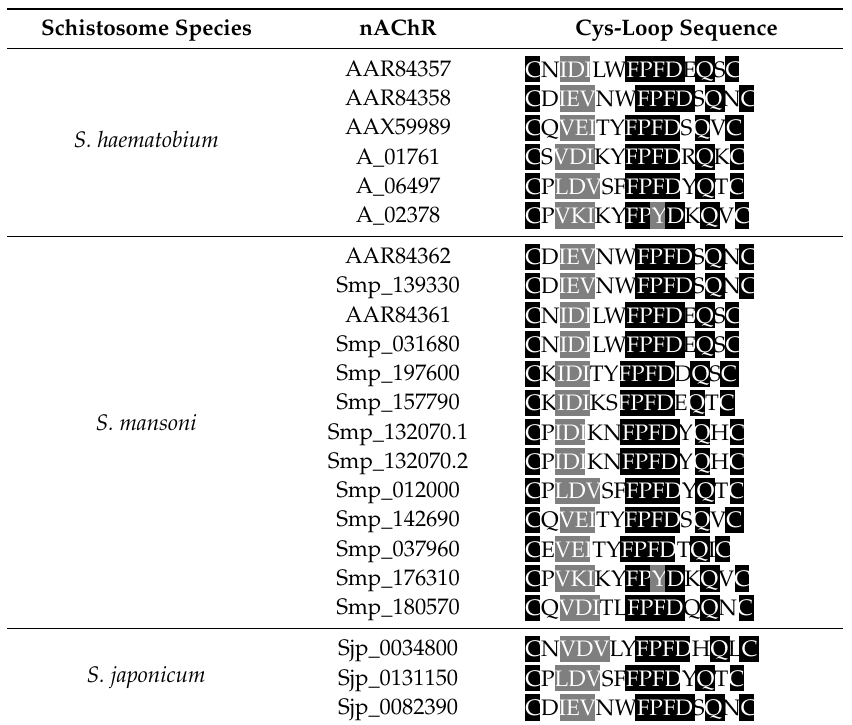
Table 2. Cys-loop motif sequences present in the nAChR subunits of S. haematobium , S. mansoni